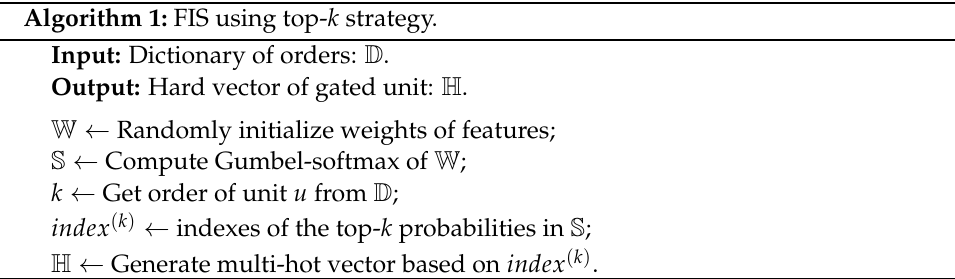
Algorithm 1: FIS using top- k strategy.